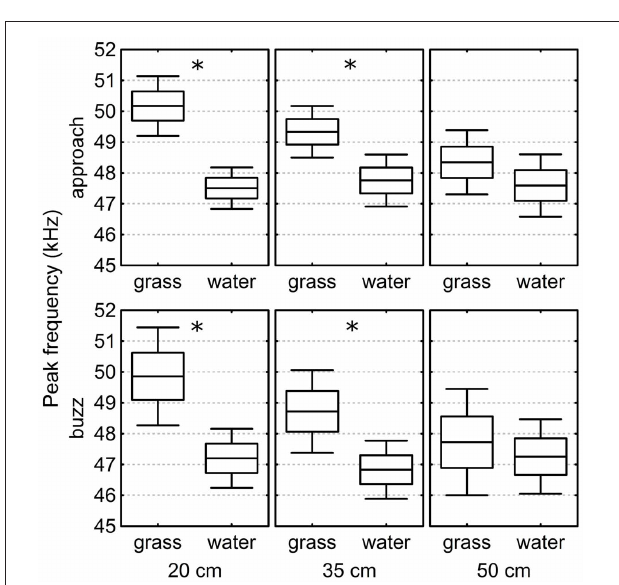
FIGURE 5 | Peak frequency of the echolocation calls above grass and water in the laboratory. In both, Buzz and Approach phase, and at target heights of both 20 and 35cm, the peak frequency was significantly higher above grass than above water. At 50cm height we found no significant differences in the peak frequency between the two surfaces. The box-plots show the mean, the standard error, and the confidence interval. Stars indicate significant differences (p < 0.001) (see call analysis section).